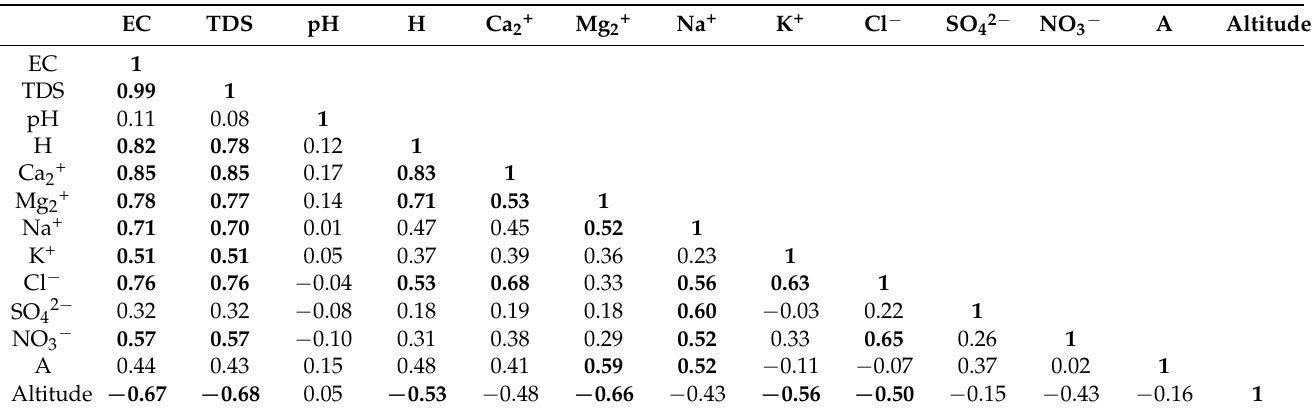
Table 2. Pearson correlation coefficients for analyzed